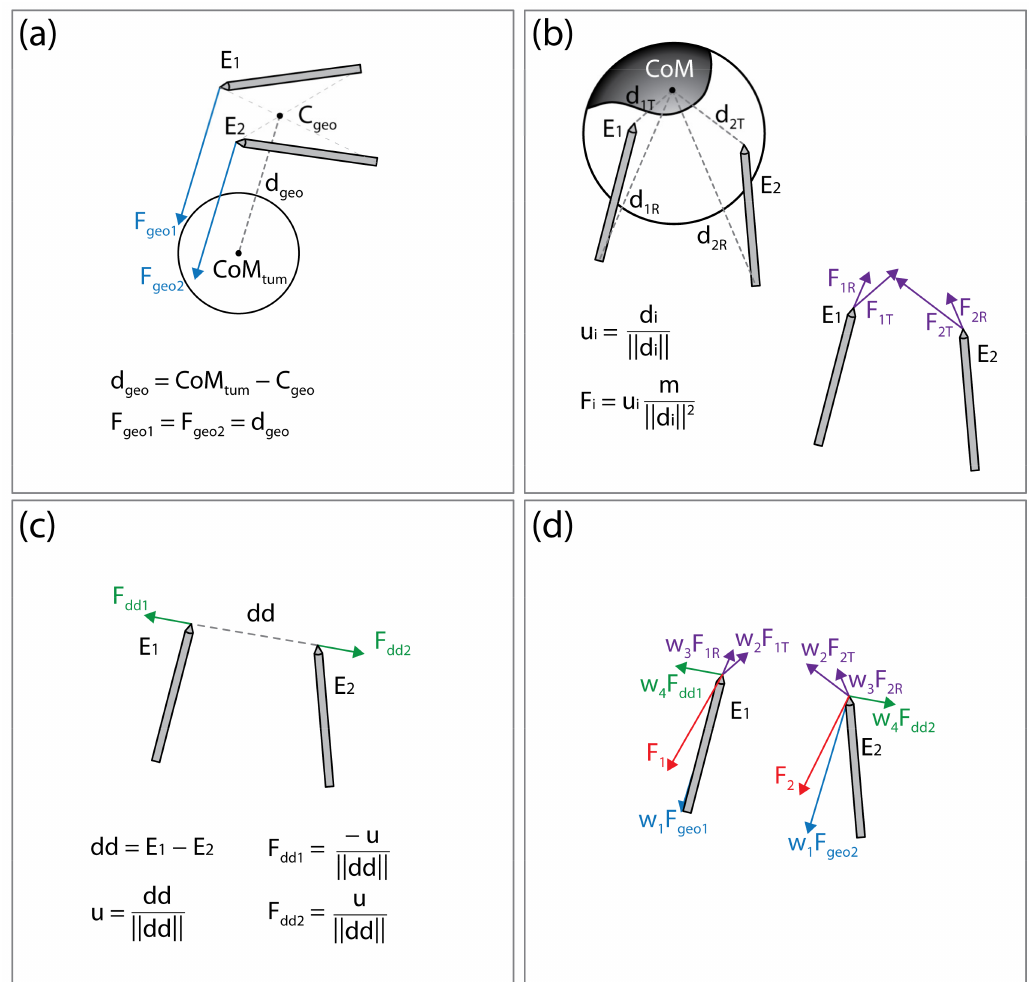
Figure 5. Illustration of the forces acting on the electrodes. ( a ) Attractive force ( F geo1 , F geo2 ) toward the tumor’s center of mass ( CoM tum ). ( b ) Attractive force (at the electrode tip, F iT , and rear F iR ) toward the undertreated areas of the clinical target volume. ( c ) Repulsive force ( F dd1 , F dd2 ) maintaining appropriate distance between electrodes. ( d ) Final forces ( F 1 and F 2 ) acting on the electrodes are a weighted sum of all forces. This figure is for illustration of the concept only; distances, vectors, and sums do not represent actual